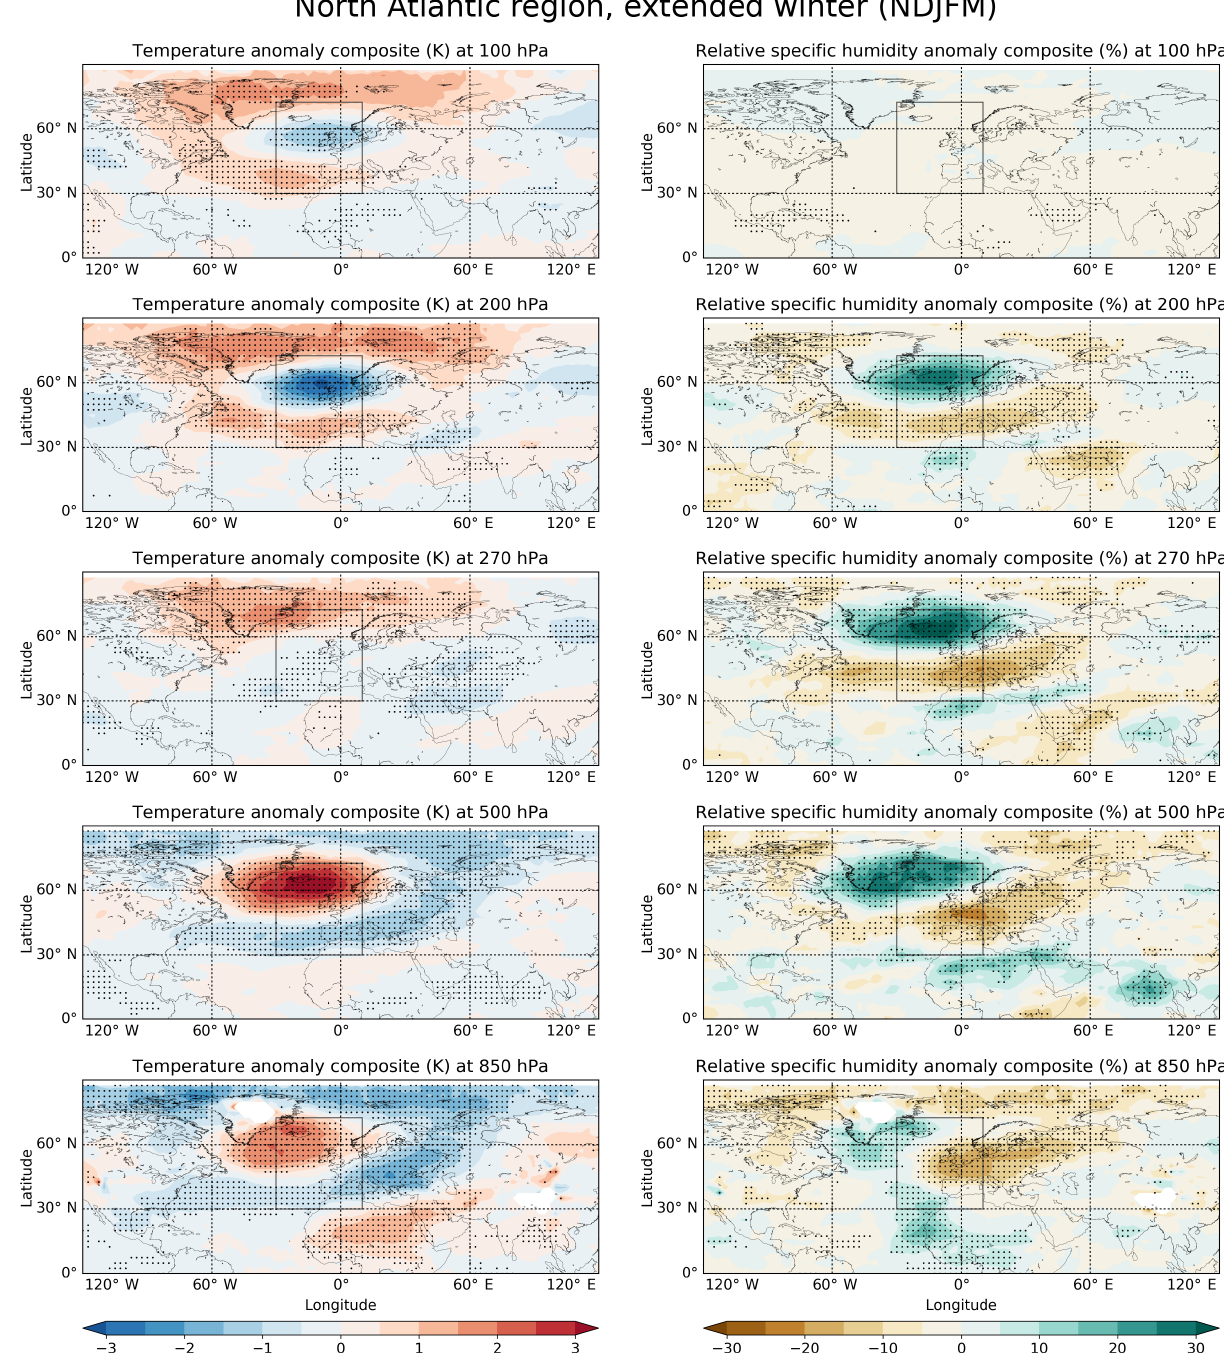
Figure 5. Composites of (a) temperature anomalies and (b) relative specific humidity anomalies during blocked days in the North Atlantic region between 30 ◦ W–10 ◦ E and 30–72.5 ◦ N (grey box; 267 days in total). Shown is the northern hemispheric extended winter (NDJFM) season. Hatched regions denote statistical significance at the 5th and 95th percentile